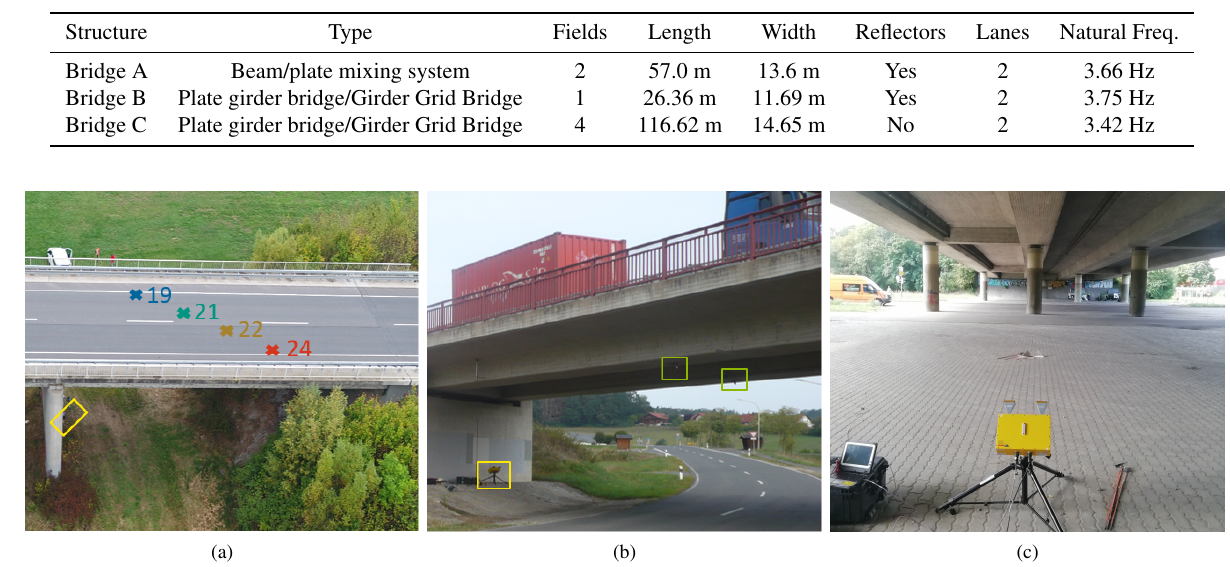
Table 1. Overview of selected bridge details.